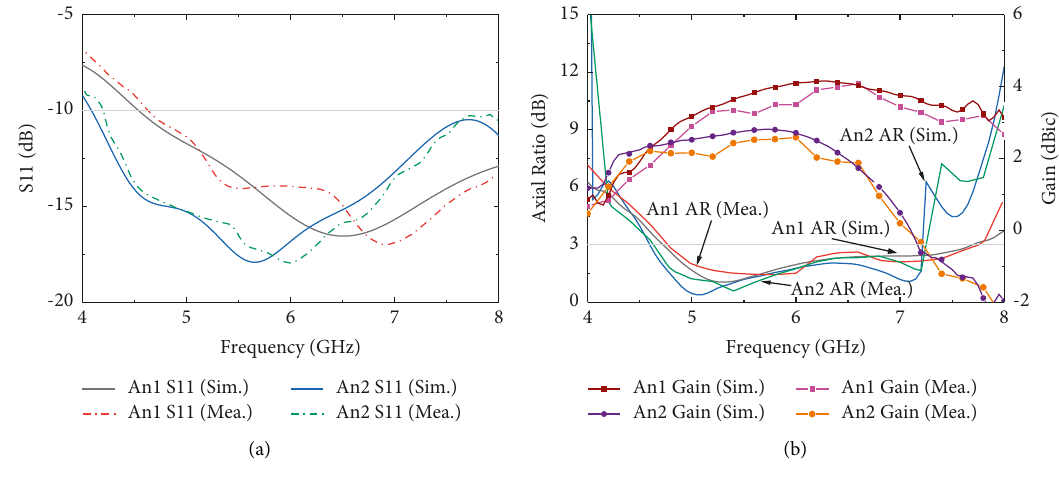
Figure 13: Simulated and measured (a) S11. (b) AR and